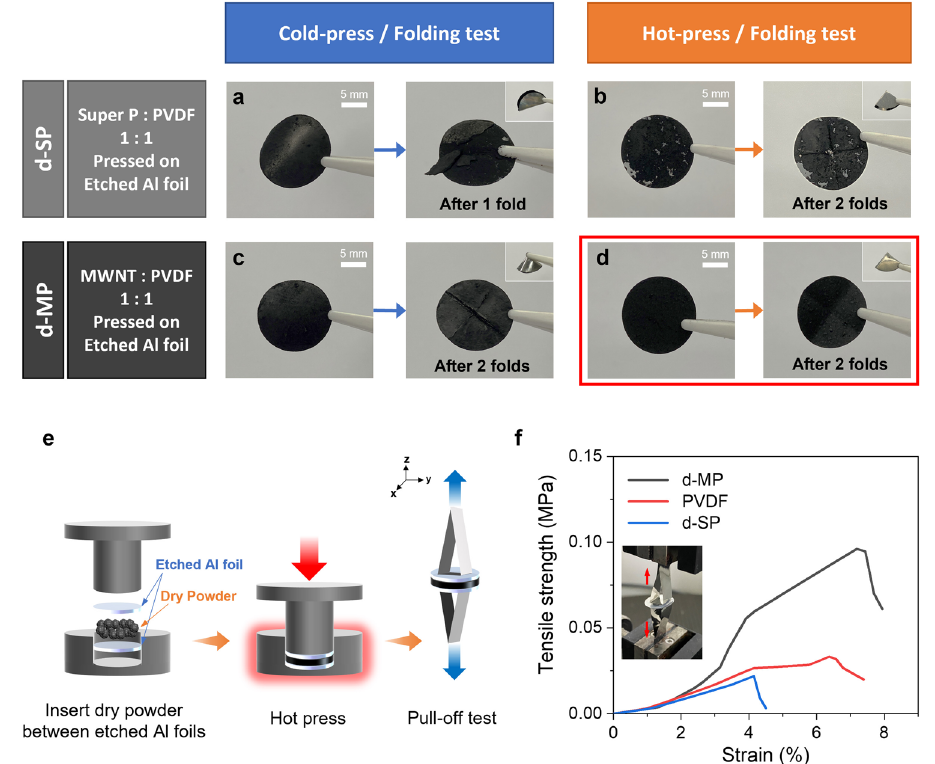
c , d . e Schematic illustration of the tensile strength measurement setup. f Comparison of the stress-strain curves of d-MP, PVDF, and d-SP sandwiched dry electrode; diameter of the disc is